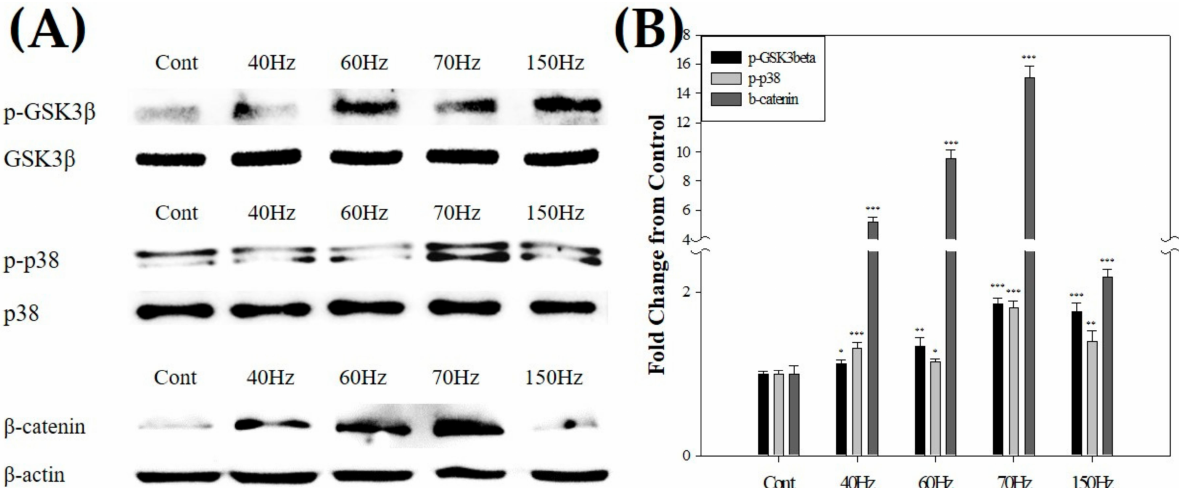
Figure 7. ( A ) Western blot of β -catenin, p-GSK3 β , and p-p38 after 10 mT PEMF exposure for 3 days. ( B ) All markers were increased in the cells exposed to PEMF. PEMF-exposed groups had higher expression than the control group. * p < 0.05, ** p < 0.01, *** p < 0.005 (compared with the control). p-GSK3 β ; phosphorylated-glycogen synthase kinase-3 beta, p-p38; phosphorylated-p38, PEMF; pulsed electromagnetic field. Cont = control (no PEMF